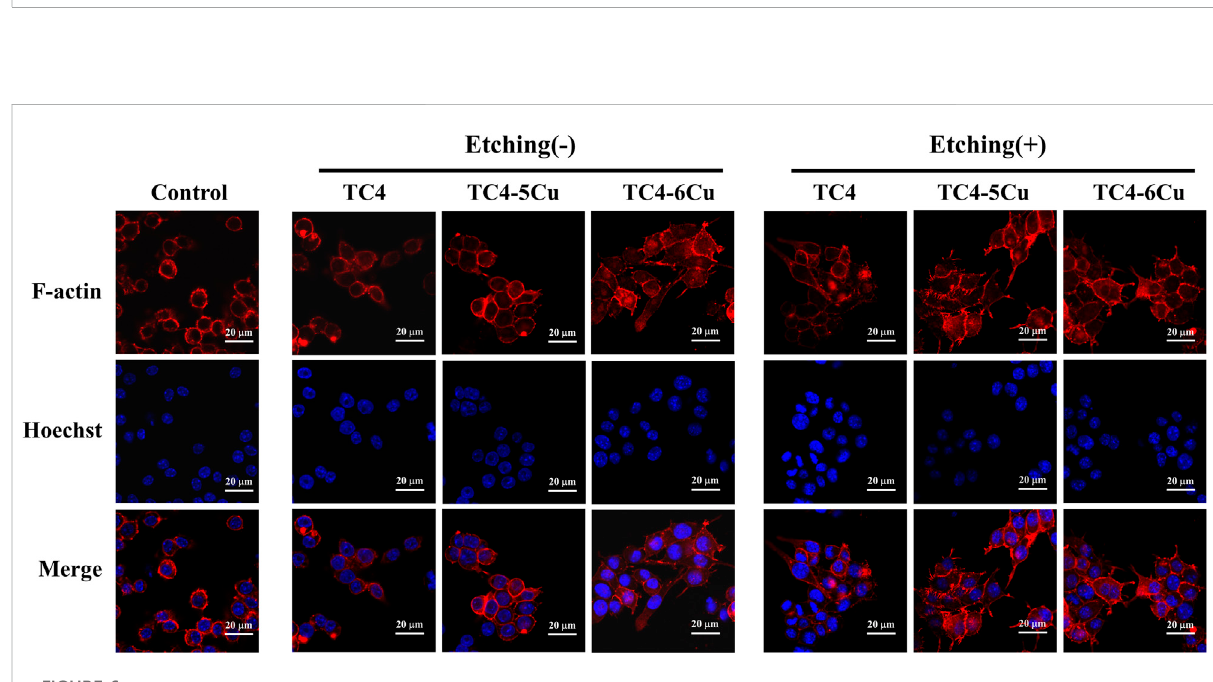
FIGURE 6 Morphology of RAW 264.7 cells cultured in different alloy extracts for 24